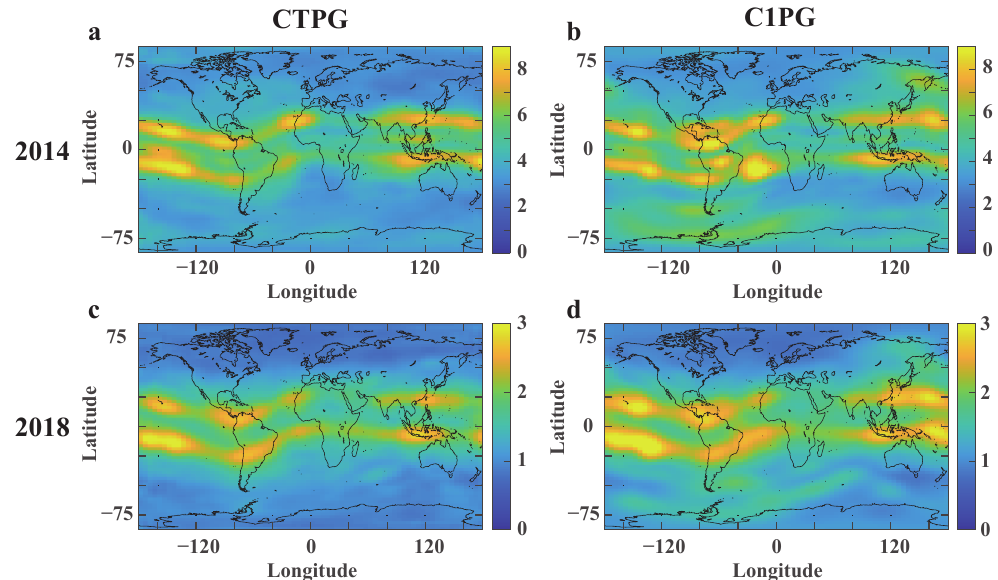
Figure 7. RMSE values between predicted TEC maps (CTPG and C1PG) and the IGS TEC maps (CODG) in 2014 and 2018. ( a ) RMSE of CTPG in 2014. ( b ) RMSE of C1PG in 2014. ( c ) RMSE of CTPG in 2018. ( d ) RMSE of C1PG in 2018.